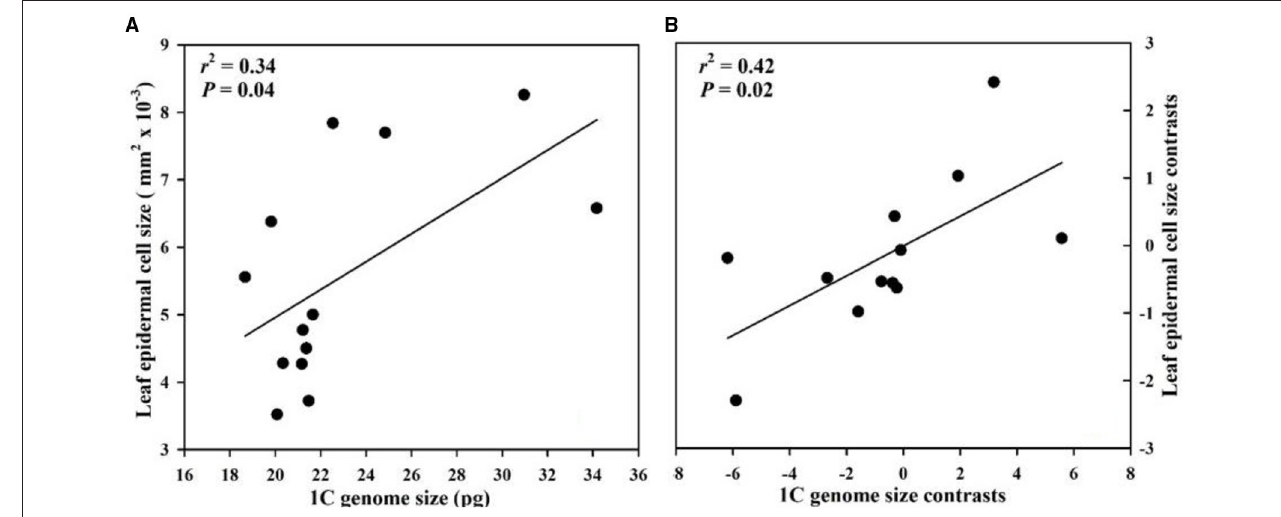
FIGURE 3 | Correlations between genome size and leaf epidermal cell size from 13 Paphiopedilum species. (A) Pearson’s regressions; (B) phylogenetically independent contrast